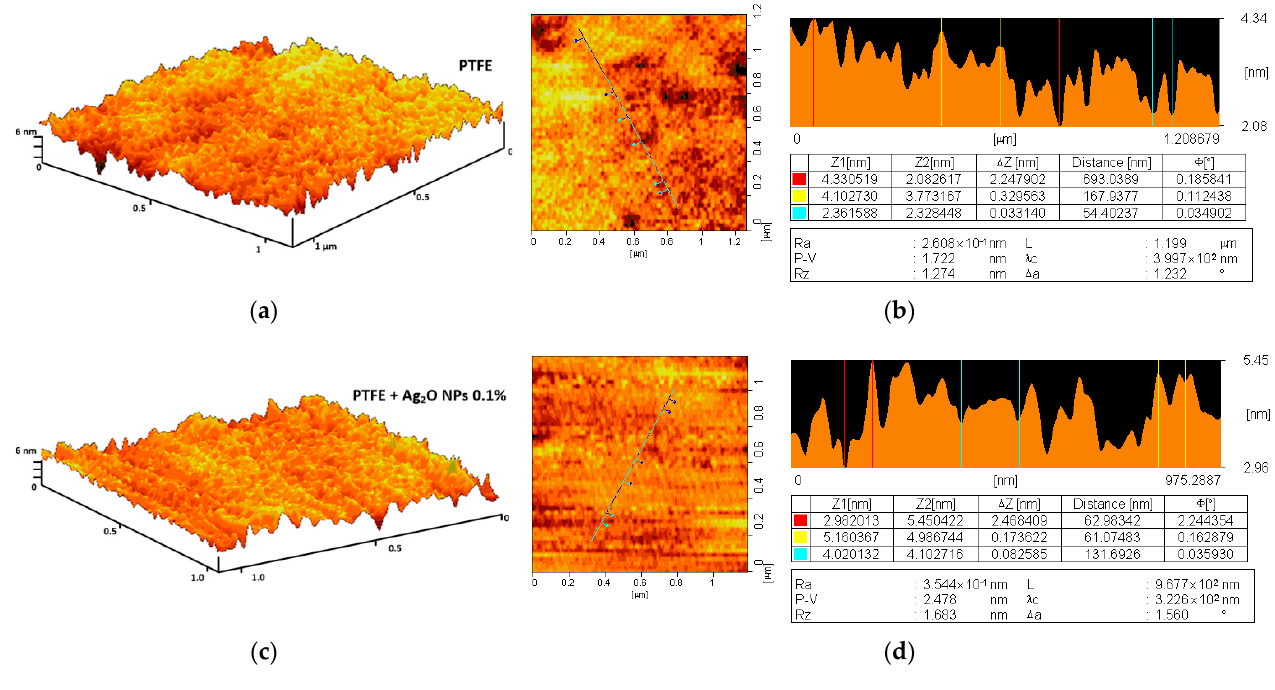
Figure 3. Investigation of the microrelief of a composite material using the AFM method: 3D reconstruction of the surface of a PTFE coating without NPs ( a ) and with the addition of 0.1% Ag 2 O NPs ( c ); examples of the results of a quantitative assessment of the surface inhomogeneity of a PTFE coating without NPs ( b ) and with the addition of 0.1% Ag 2 O NPs ( d ).